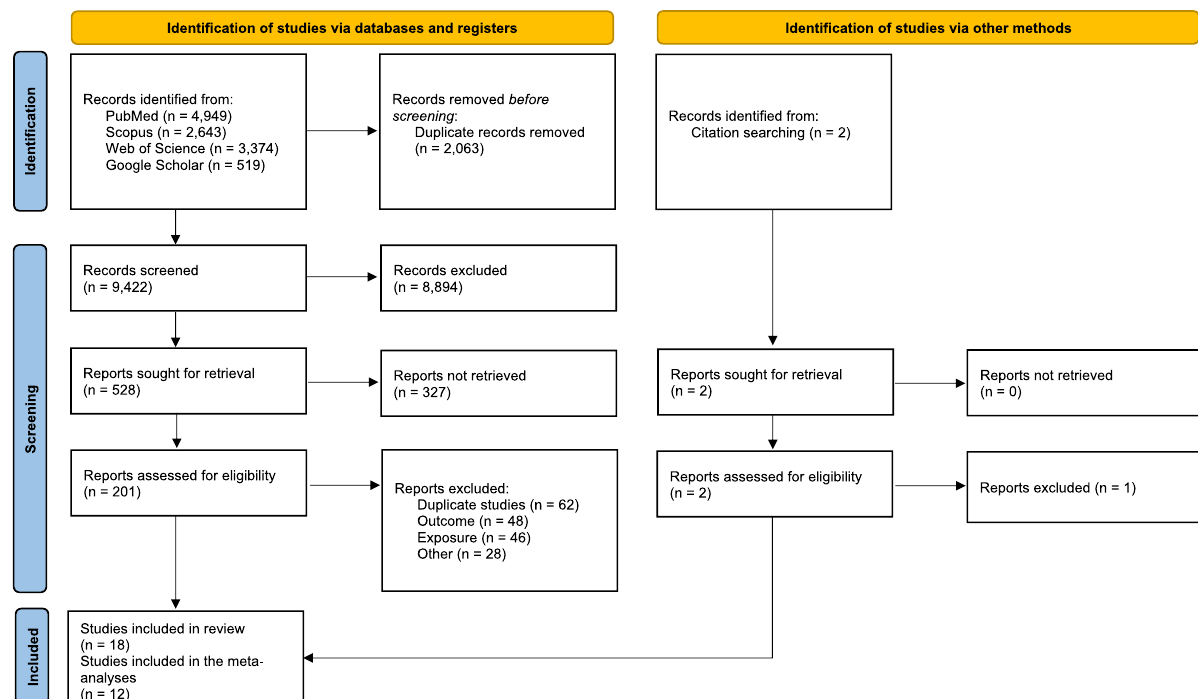
Figure 1. Preferred Reporting Items for Systematic Reviews and Meta-Analyses 2020 flow diagram for new systematic reviews which included searches of databases, registers and other